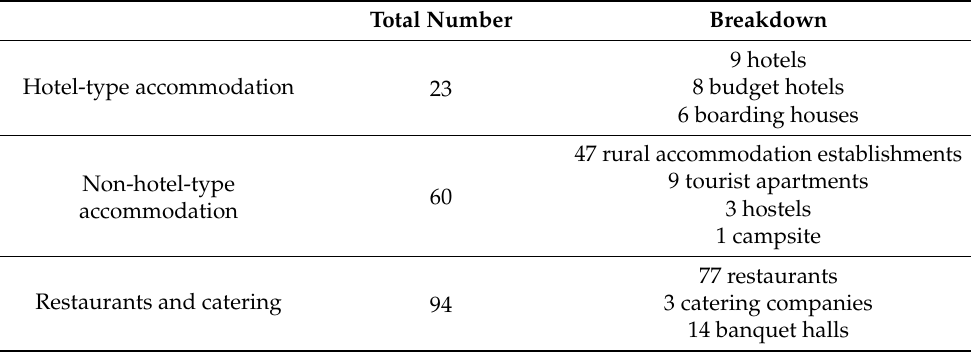
Table 1. Accommodation establishments and restaurants in Monfragüe National Park.